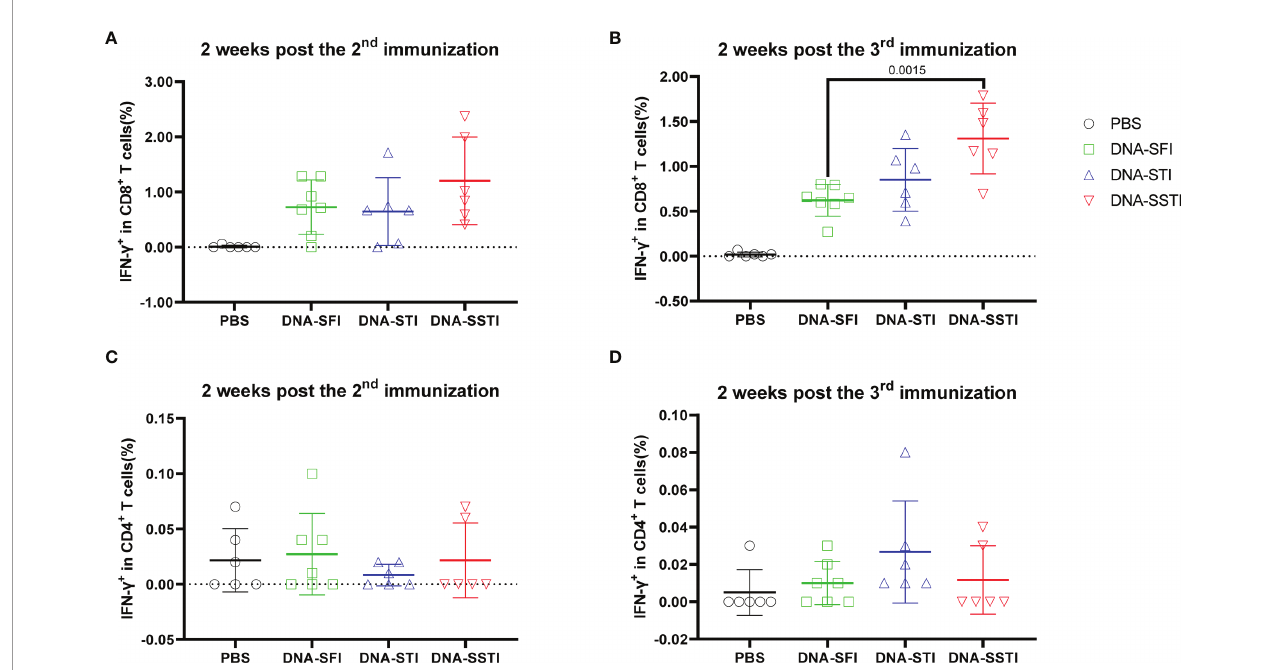
FIGURE 3 | Frequencies of circulating S protein speci fi c IFN- g secreting CD8 + T cells elicited by the DNA vaccine at 2 weeks post the 2 nd and 3 rd immunization. Peripheral blood were collected from mice immunized with the DNA vaccine at 2 weeks post the 2 nd and 3 rd immunization. S protein speci fi c IFN- g secreting CD8 + T cells (A, B) and CD4 + T cells (C, D) in peripheral blood were detected by intracellular cytokine staining (ICS). Data are shown as mean ± SD. Statistical analyses were performed using the method of